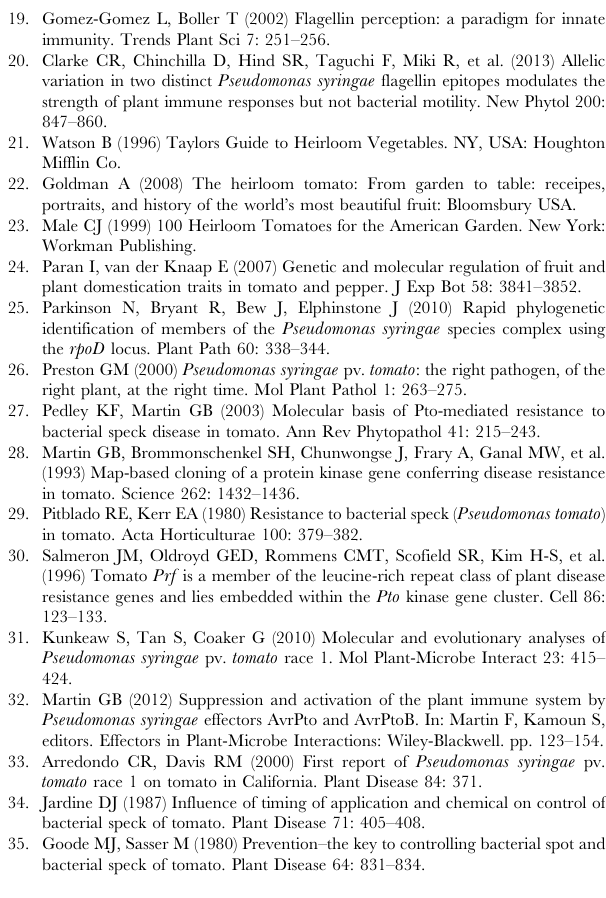
Figure S5 The heirloom lines do not have the Pto gene. PCR products diagnostic for resistant or susceptible Pto haplotypes were amplified from genomic DNA and digested with FokI. The product at about 900 bp (red arrow) is diagnostic of the Pto gene (present in RG-PtoR and Ontario 7710). The product at about 250 bp (black arrow) is diagnostic of lines lacking Pto (such as RG-PtoS and Moneymaker). None of the heirlooms appear to have the Pto gene. Figure S6 Heirloom tomato lines showed differential susceptibility to North Carolina isolate NC-C3. Photos of bacterial speck disease on plants from the field inoculation experiment using North Carolina isolate NC-C3. Photographs were taken on the 7th day after inoculation. Red arrows point to signs of the disease.